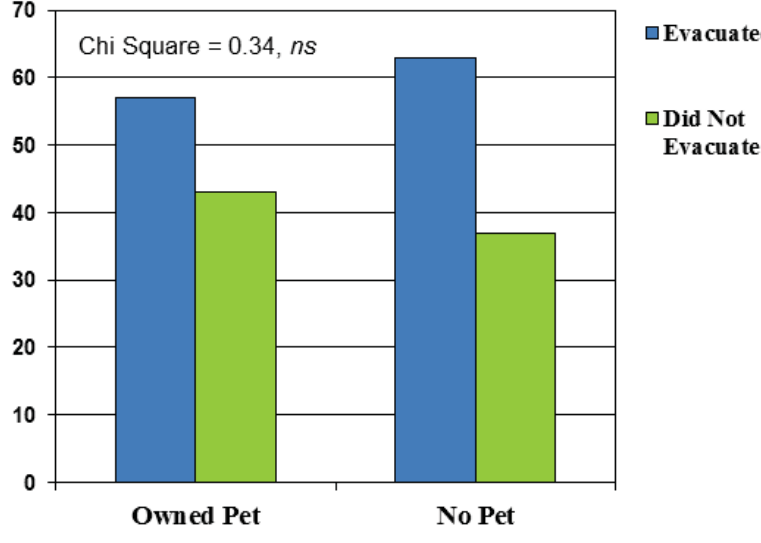
Figure 1. Percent of households evacuating among pet owners and non-pet